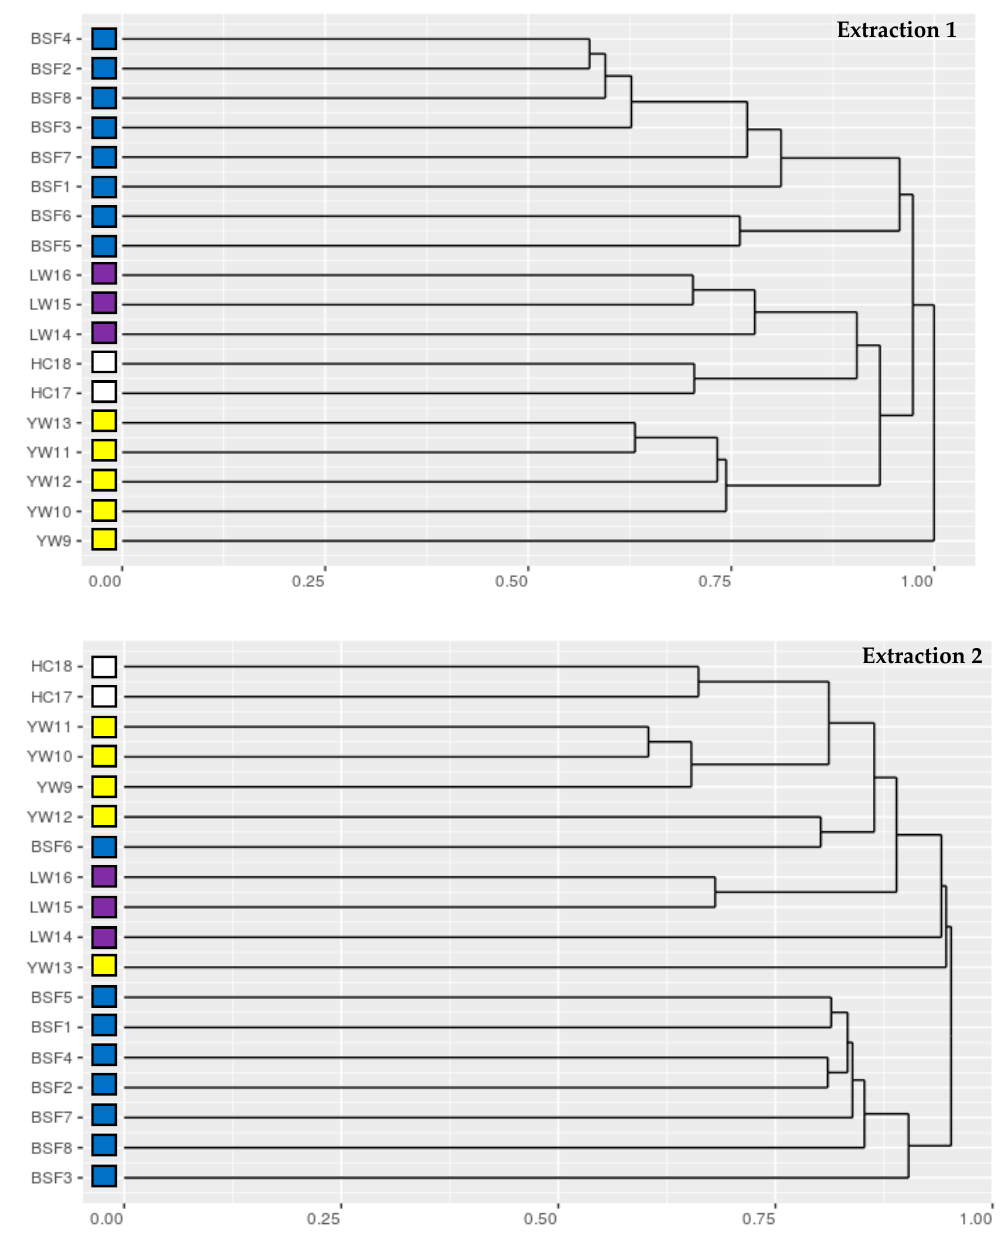
Figure 3. Species specific insect meal samples differentiation. Direct comparison of spectra obtained by tandem mass spectrometry usingDISMS2. With two exceptions (BSF6 and YW13 in Laboratory B) insect meal samples cluster according to the taxonomic classification of the insect species.